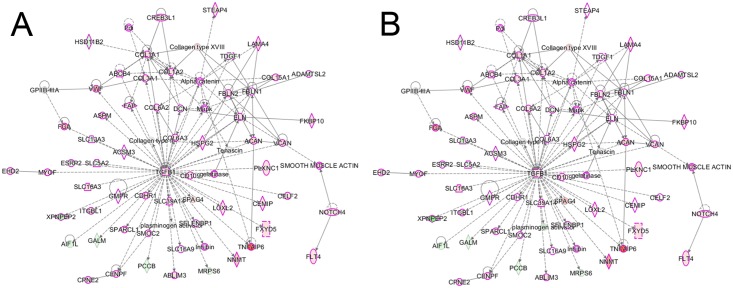
Gene network.The most differentially affected network with the central role of TGFB1 in (A) FFPE samples and B) RNAlater data sets. Proteins with cancer involvement are marked with purple outline. Red fill indicates overrepresentation of the gene in ccRCC, green indicates under-representation. Color intensity reflects range of fold change.